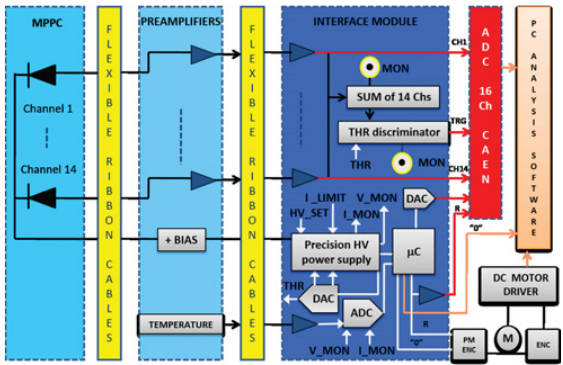
Figure 5. Structure and data flow of the data acquisition system. Details are described in the text.